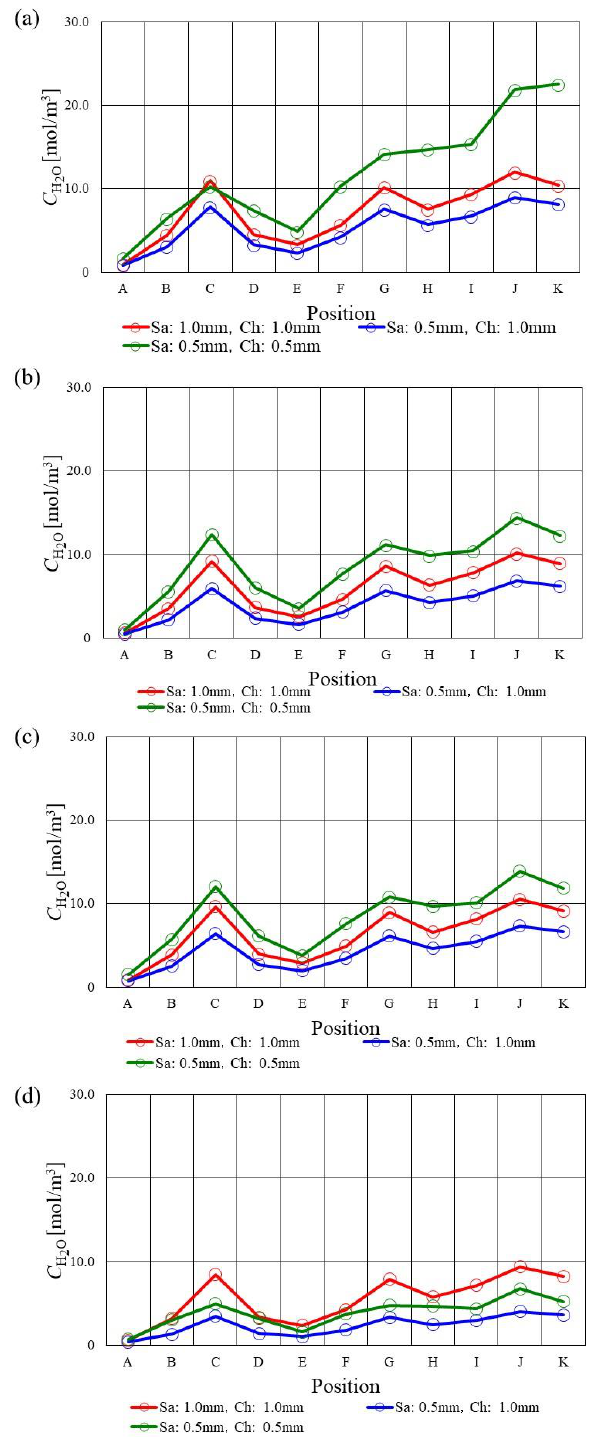
Figure 8. Molar concentration of H 2 O along with the gas channel on the interface between PEM and catalyst layer at the cathode among various s.t. at T ini = 353 K. ( a ) A80%RH/C80%RH, ( b )